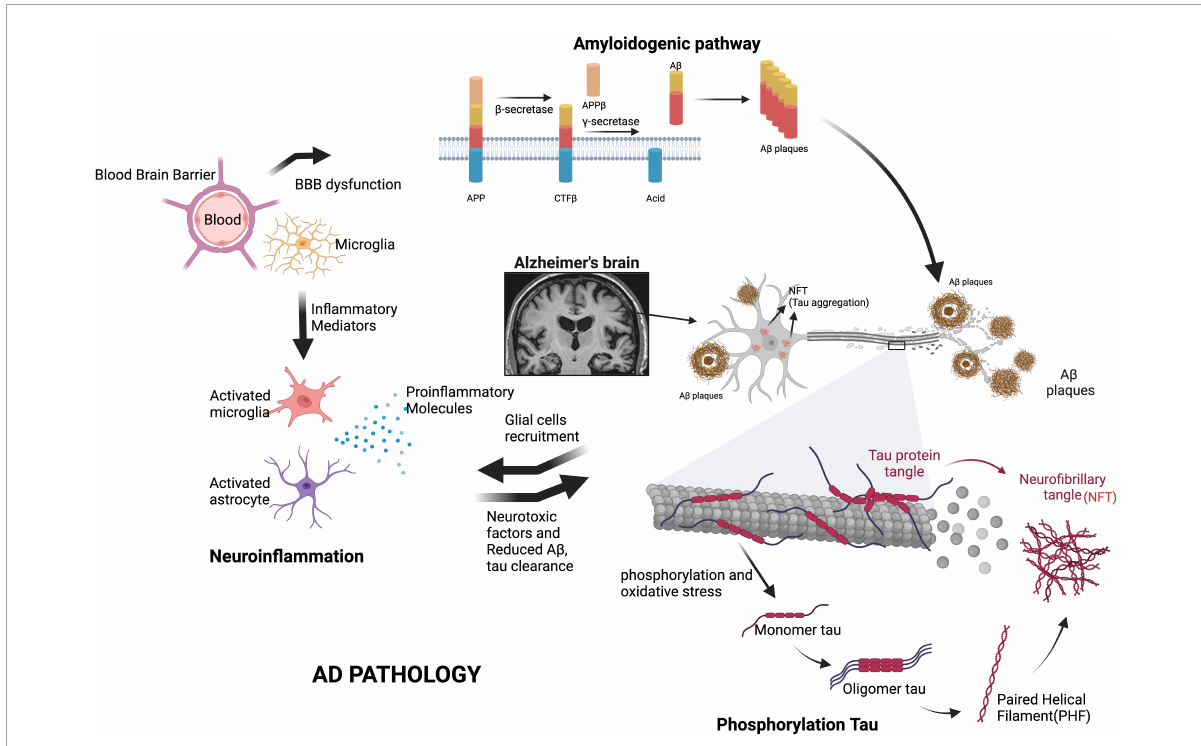
FIGURE1 Key factors in AD pathogenesis. The formation of amyloid plaques through the overexpression of APP, tau hyperphosphorylation and NFT pathology, neuroinflammation, mitochondrial dysfunction and oxidative stress, translocation of harmful gut substances through a permeable BBB, and the eventual loss of synaptic function are the main causes of AD. Additional glial cell recruitment by proinflammatory mediators dysregulates A β and tau clearance, further contributing to neurodegeneration. A β , amyloid beta; APP, amyloid precursor protein; CTF β , neurotoxic C-terminal fragment; BBB, blood-brain barrier. We have obtained the appropriate licenses from BioRender for this